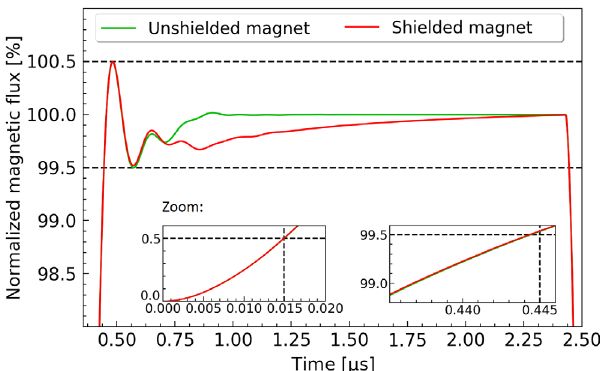
FIG. 17. Comparison of the predicted normalized magnetic flux for a 20-cell FCC injection kicker magnet with the beam screen (red curve) and without the beam screen (green